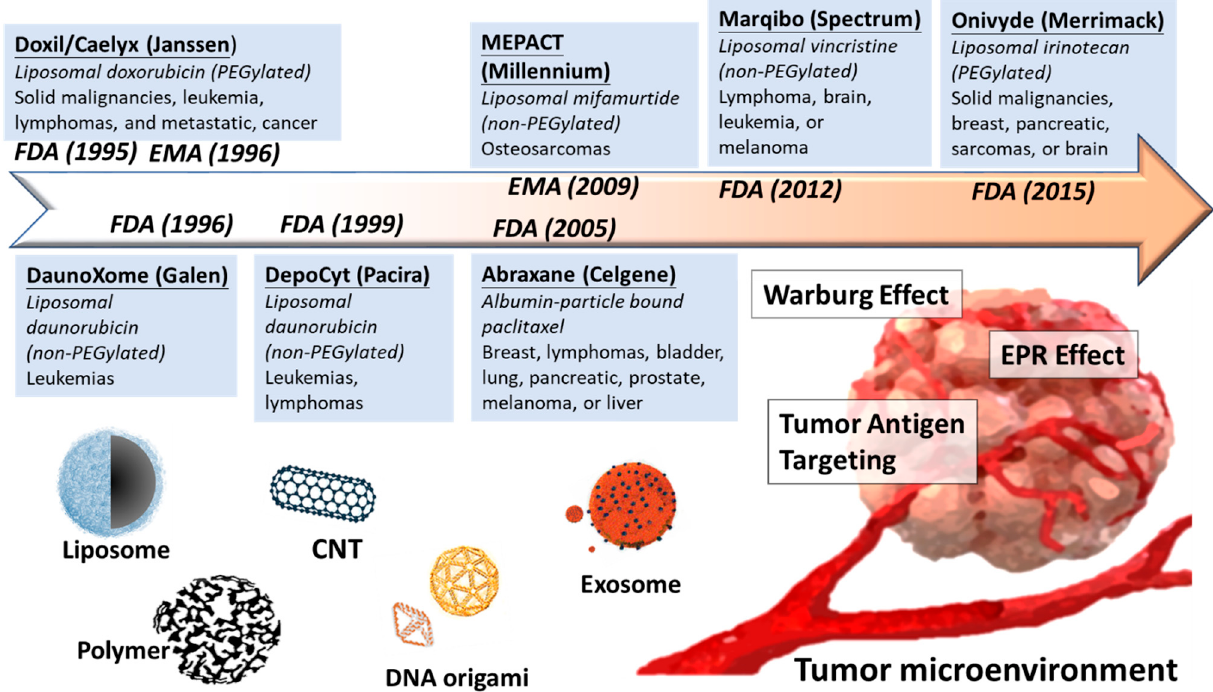
Figure 1. Development for nanomedicine reaching for tumor microenvironment. In past decades, plenty of nanocarriers are moving from preclinical bench work into clinical trial and finally approved for cancer therapy. The driving force of nanomedicine toward tumor microenvironment could be passive or active. Passive delivery relies on loose tumor vessels (EPR effect) and low pH (Warburg effect), while the active delivery can directly recognize tumor antigens by conjugating high-affinity molecules. Various novel and advanced materials of nanocarriers are designed for drug delivery, including liposome, polymer, CNT, DNA origami, and exosome. Table 3. Properties of different nanomaterials.